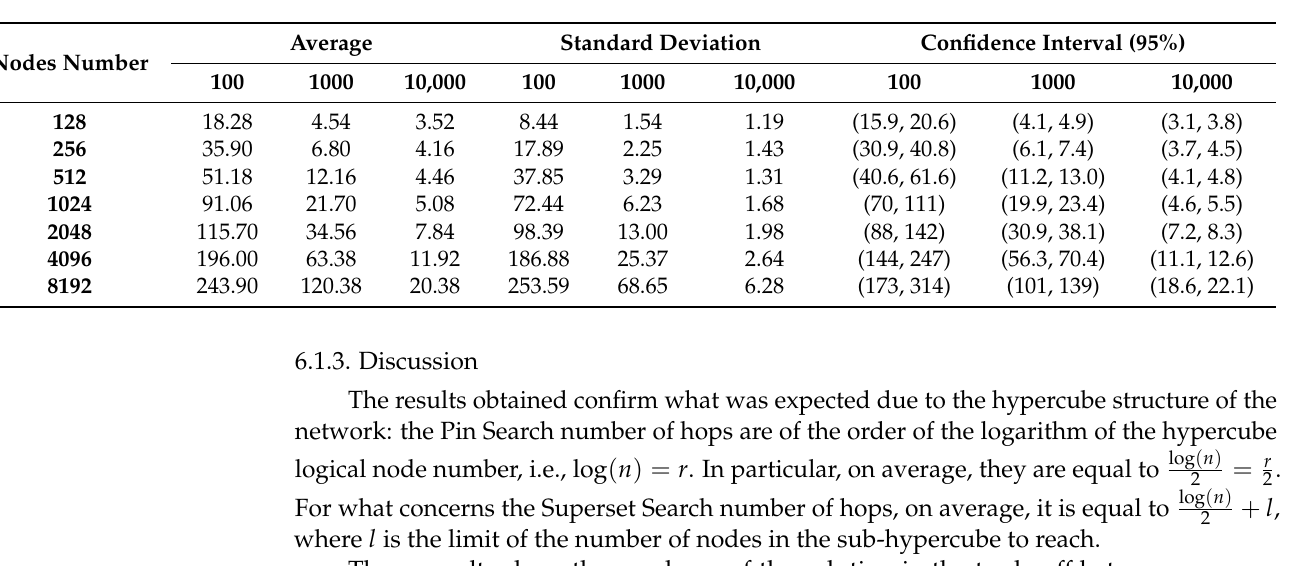
Table 2. Superset Search number of